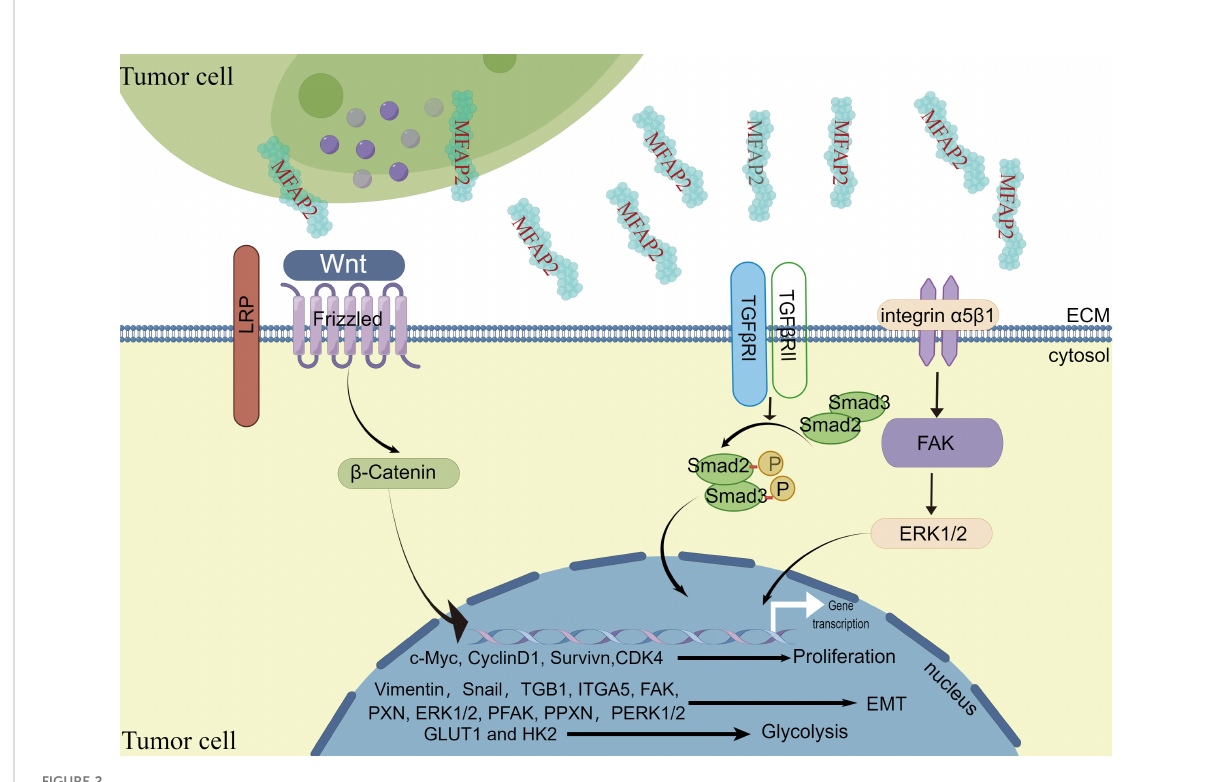
FIGURE 2 The carcinogenic effect of MFAP2 and its